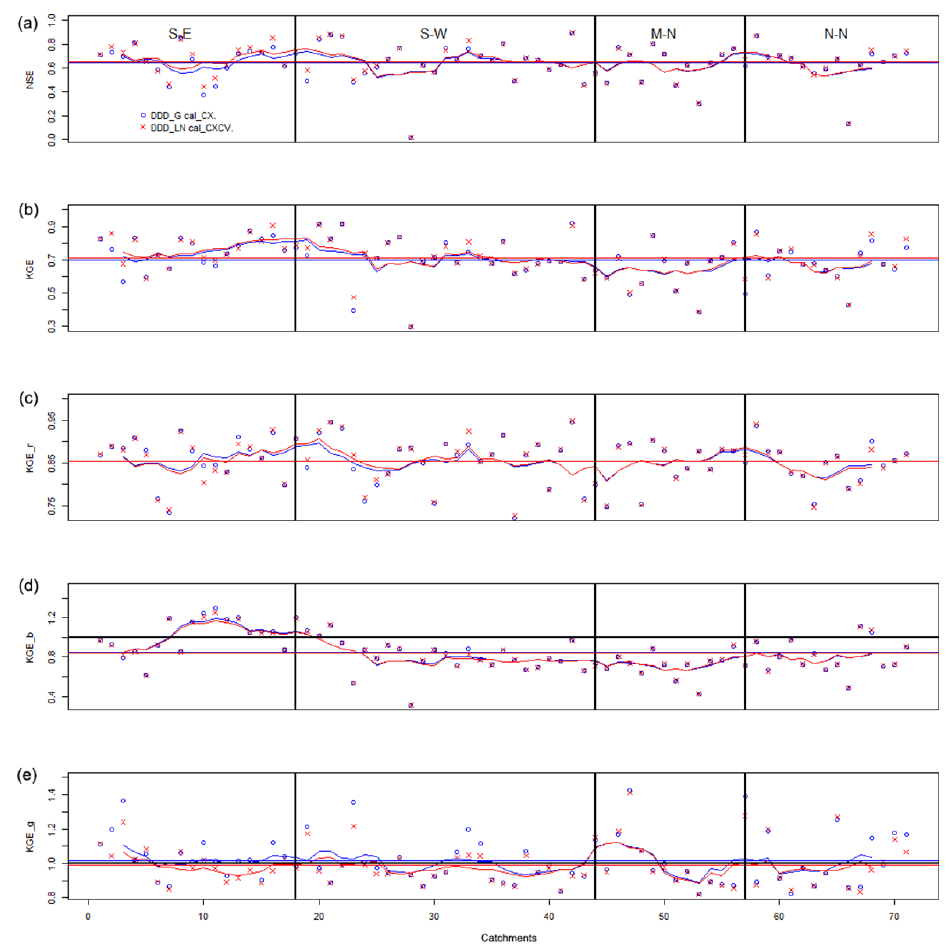
Figure 5. Skill scores for DDD_G (blue circles) and DDD_LN (red crosses) for 71 Norwegian catchments. Mean skill score values are shown in horizontal lines along with moving averages (same colour code). (a) NSE, (b) KGE, (c) KGE_r (correlation), (d) KGE_b (bias) and (e) KGE_g (variability error). The results are organized into the regions south-east (S-E), south-west (S-W), mid-Norway (M-N) and Northern Norway (N-N) as indicated in Fig. 3. Table 3. Spearman correlations between simulated model results and catchment characteristics for the validation period 2000–2014. Only significant correlations are shown ( p value<0.01) except for the correlation marked ∗ , which has a p value slightly larger than 0.01 ( p value = 0.013). Catchment size Lake (%) Bog (%) Bare rock (%) Forest (%) Mean